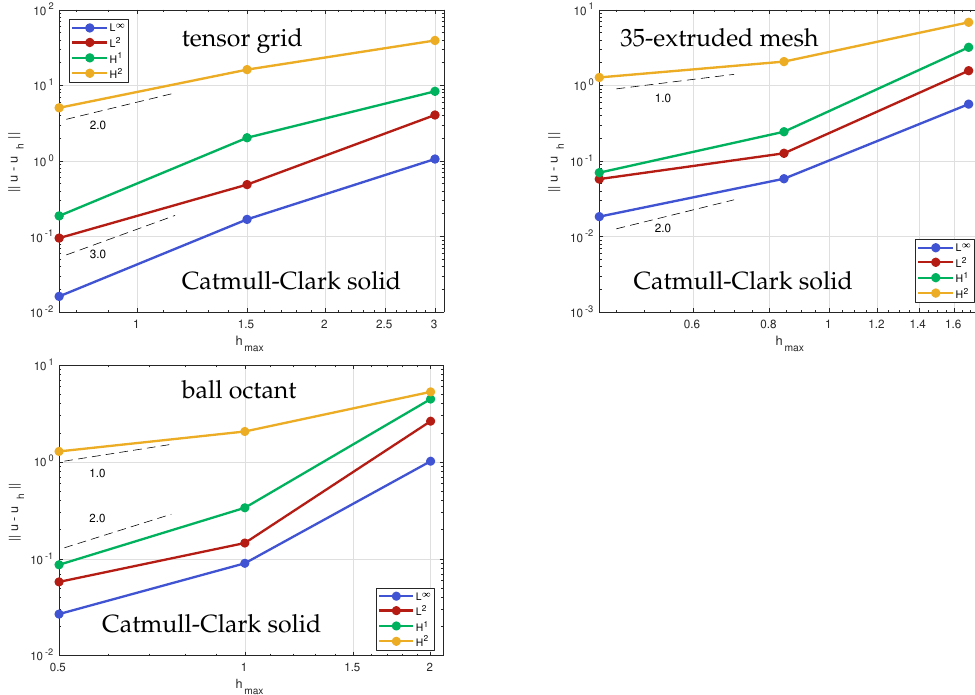
Figure 9. Volumetric Catmull-Clark convergence of the error for the biharmonic problem.